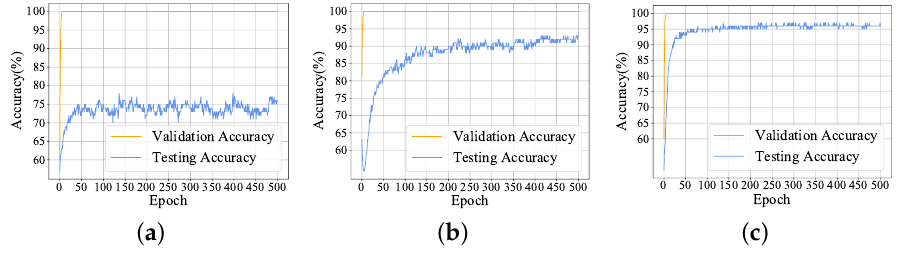
Figure 15. Comparison results of validation accuracy and testing accuracy with different numbers of training samples: ( a ) 1000 training samples; ( b ) 1400 training samples; ( c ) 2000 traning samples.